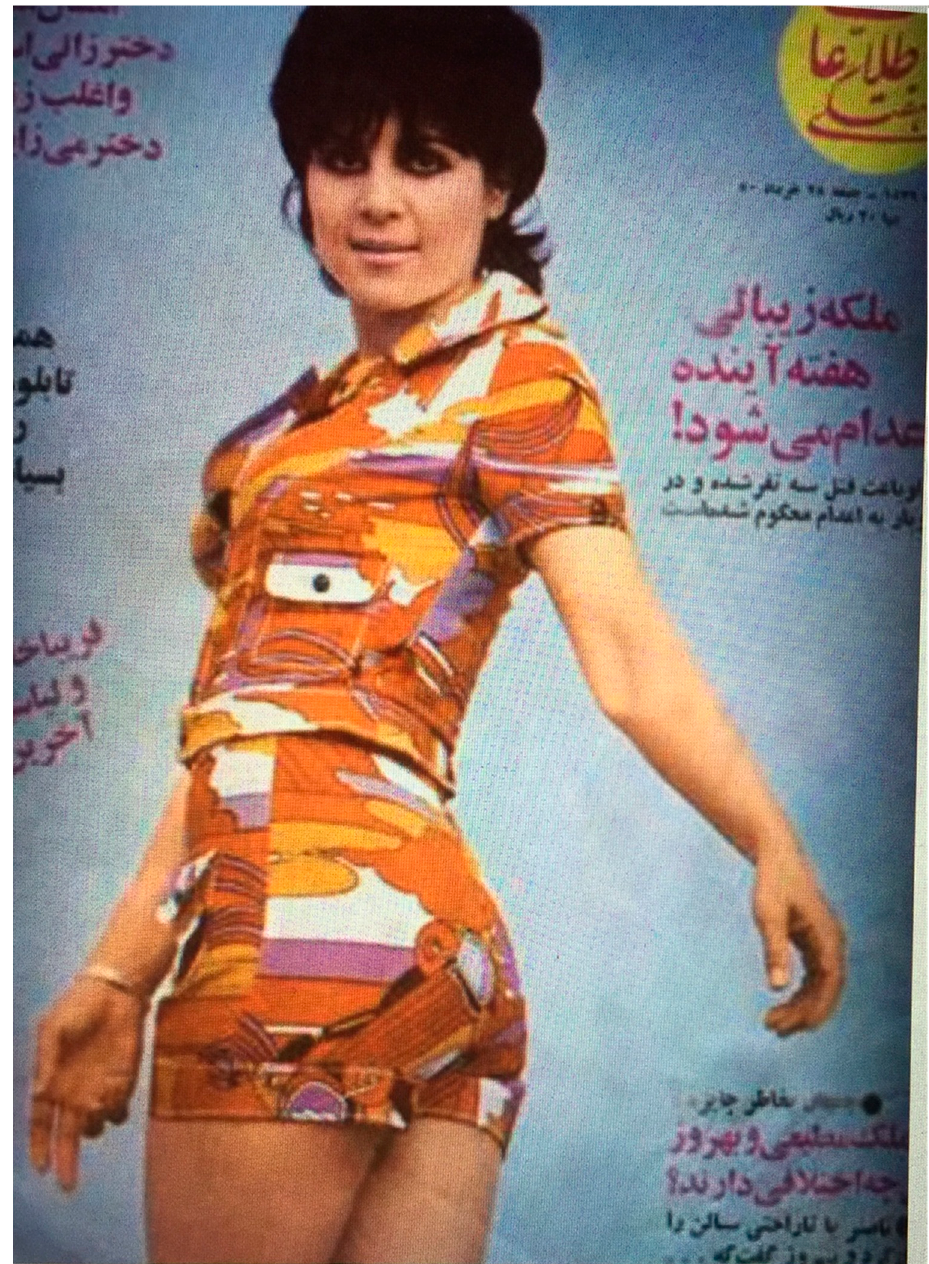
Figure 3. Cover of Etela’at e Haftegi (Weekly News) Magazine 1970s. http://www.parstimes.com/fashion/pre_revolution/.